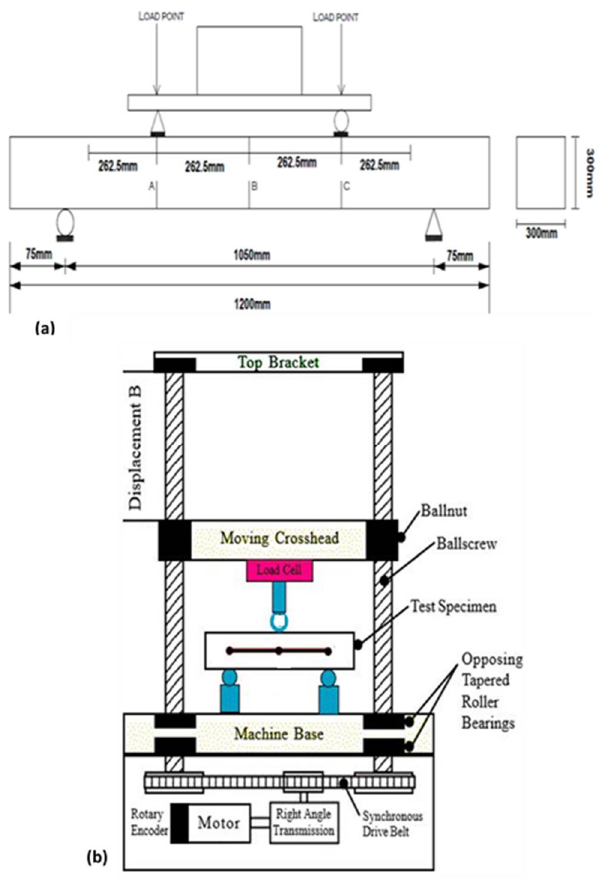
Figure 7. ( a ) Loading details of bending test on the control and corroded beam; ( b ) schematic arrangement of testing equipment.